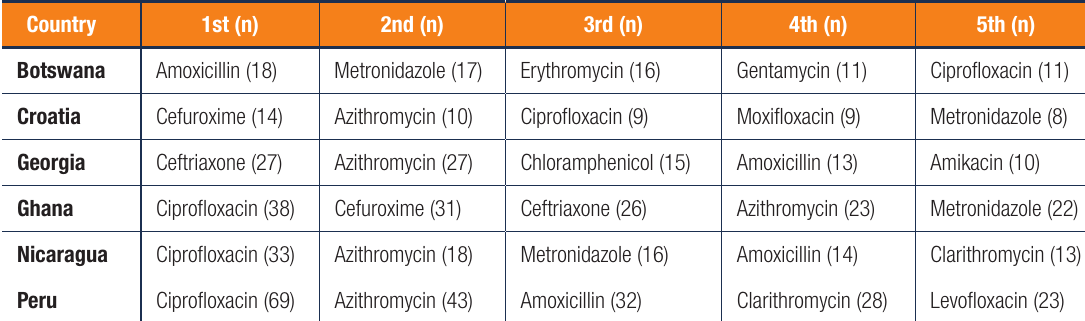
FIGURE 14. Top Five Active Ingredients According to Number of Brand Names